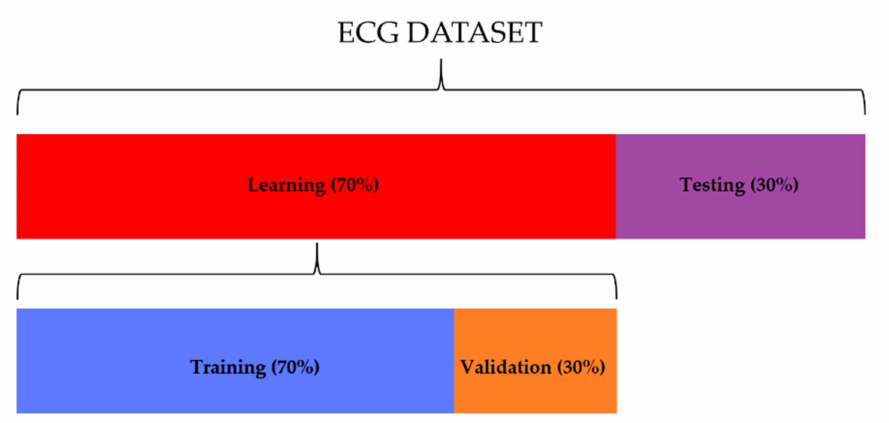
Figure 4. The distribution of ECG segments used for learning (70%) and testing (30%). Thirty percent of the learning dataset was used for the validation of the